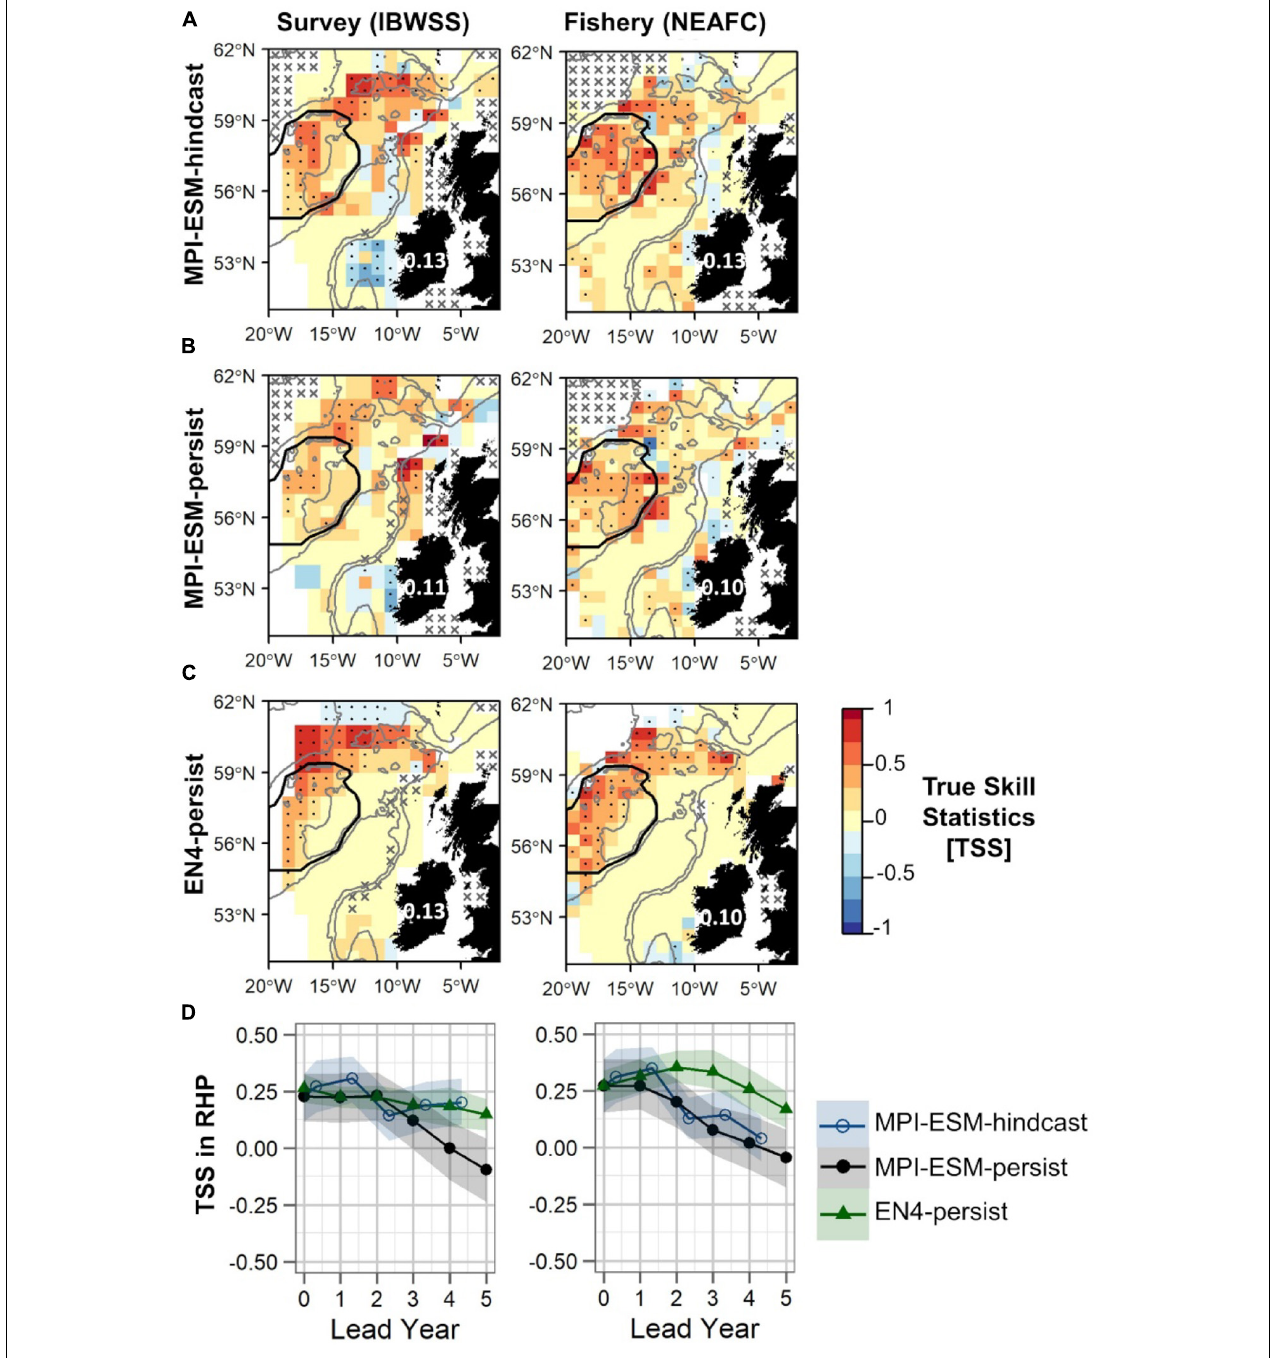
FIGURE 10 | Predictive quality of retrospectively forecasted suitable spawning habitat based on the suitable salinity for spawning with MPI-ESM-hindcast (A) , MPI-ESM-persist (B) , and EN4-persist (C) in terms of the True Skill Statistics (TSS) for March and April judged against observations of adult blue whiting from surveys (IBWSS) (left) and fishery (NEAFC) (right) approximately one year ahead (A–C) ; and spatially averaged over Rockall-Hatton Plateau (RHP; region delineated in black in the maps above) for each lead year (D) . The last panel (D) shows MPI-ESM-hindcast (blue circle), MPI-ESM-persist (black bullet) and EN4-persist (green triangle) with the shaded areas indicating the spread based on the lower and the upper quartile of a 500-fold bootstrap. Retrospective forecasts are distinctly different when their respective shaded areas do not overlap. Due to the different initialisation dates, panels (A–C) show the hindcast with a lead time of around 16 months and the persistent forecasts with a 12 months lead. In panels (A–C) dots show significant correlations at the 95% confidence level and crosses indicate regions where the predictive skill cannot be evaluated confidently, both based on a 500-fold bootstrap. Good predictive quality (TSS > 0) is indicated by red colours (where HR > FAR) and the mean TSS within the plotted region (excluding regions with crosses) is noted over Ireland. The grey lines indicate the 600 and 2,000 m isobaths.